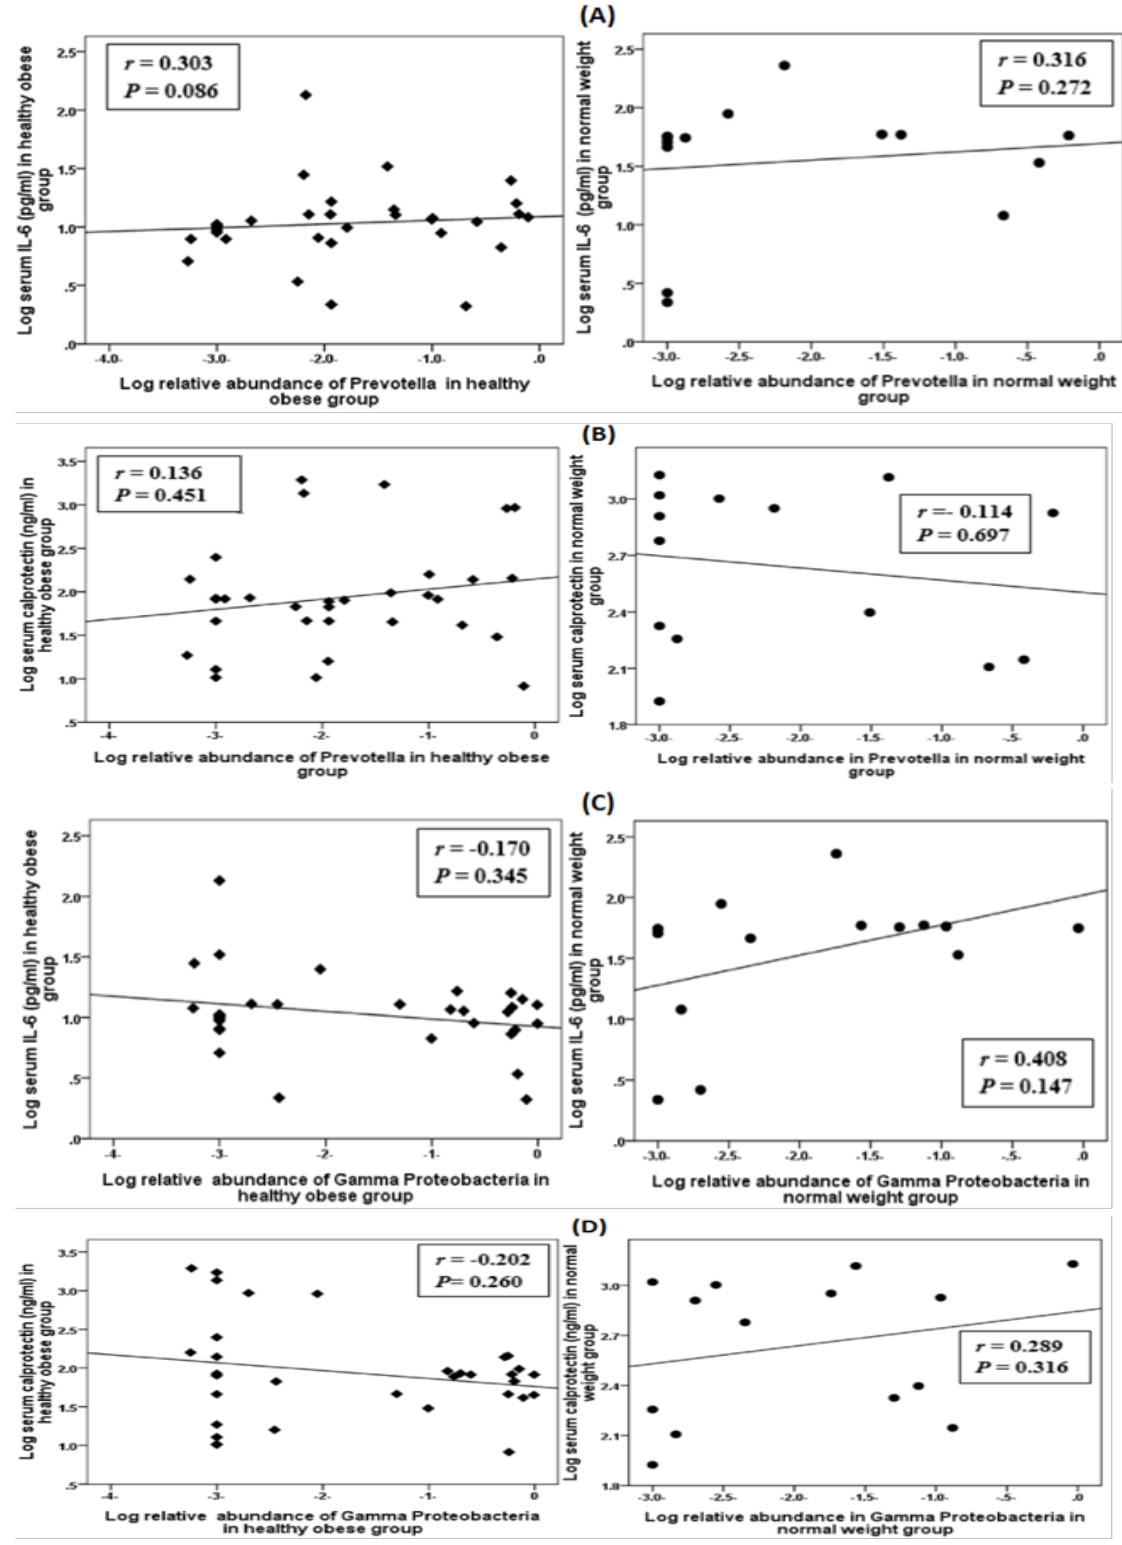
Figure 3. Correlation between the relative abundance of Prevotlla and log serum levels of IL-6 (A) and log serum levels of calprotectin (B) in healthy obese group and normal weight groups. Correlation between the relative abundance of γ- Proteobacteria and log serum levels of IL-6 (C) and log serum levels of calprotectin (D) in healthy obese group and normal weight